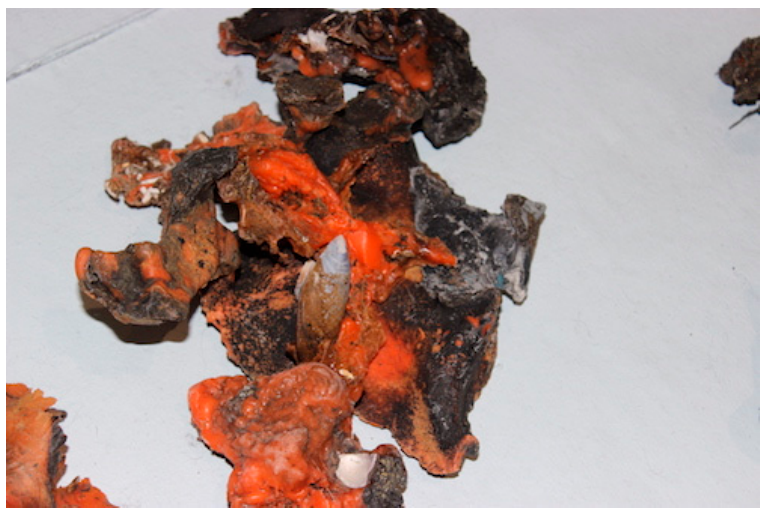
Figure 2. Plastiglomerate with embedded mussel shell. Neo Terra exhibition, Ullapool (2016). Photograph created by the author.